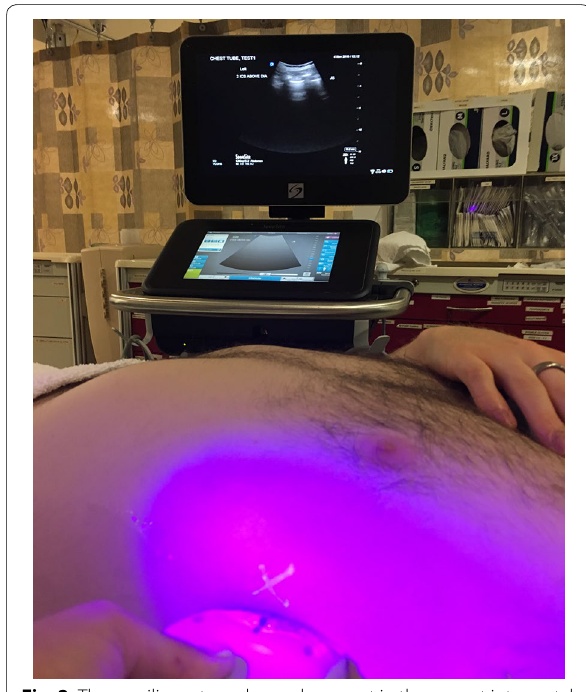
Fig. 2 The curvilinear transducer placement in the correct intercostal space. The LED flashlight has illuminated the landmark (represented by the “X” on the volunteer’s skin). On the ultrasound screen in the background, the ICS is demonstrated in the center of the screen between two rib